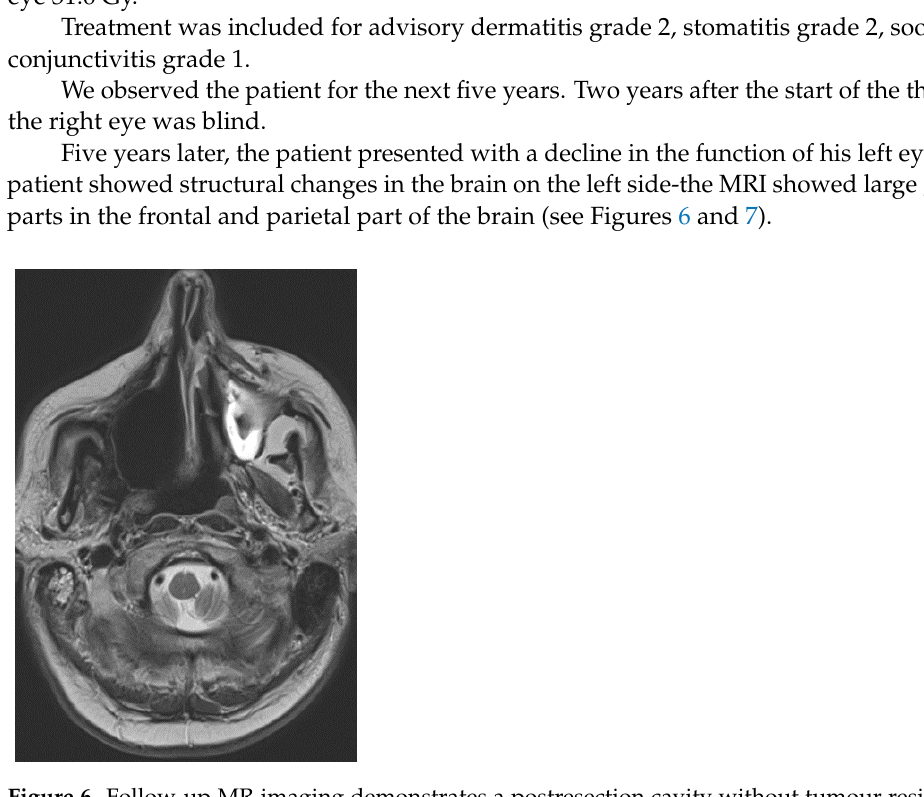
Figure 7. Follow-up MR imaging demonstrates a postresection cavity without tumour residue or recurrence in the right maxilla (5 years after surgical treatment). Coronal imaging in T1 weighting after contrast agent administration. Ancylostomiases and trismus started in the first year following the proton therapy. The patient could open his mouth 6–7 mm only, which influenced his nutritional status. The patient ingested minced food and beverages. However, his weight remained stable for five years. Postoperatively, the patient was referred from the otorhinolaryngologic surgeon to the oncologist. Regular MRI follow-up examinations were performed every 6 months. A CT scan of the lungs was performed once a year. A PET-CT was indicated in the year 2021 (4 years after proton beam radiotherapy). None of the images revealed any evidence of locoregional cancer recurrence or metastatic involvement. No local recurrence was observed (OL 0); the overall survival time has been 6 years as of the date of publication (OS 6 years); the disease free interval has been 5 years and 6 months, and no metastases were observed (MT 0). 3. Discussion Many case reports of osteosarcomas of the jaws are described, including recommen- dations for diagnostic and therapeutic management. The main reason for this report was